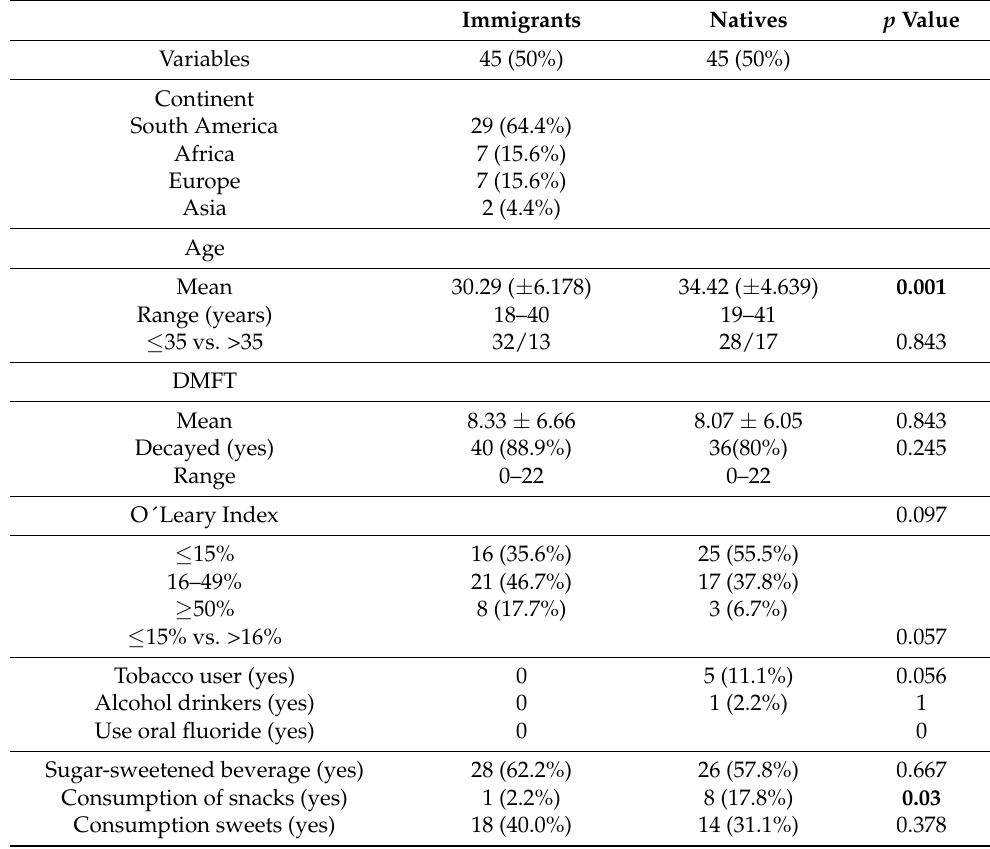
Table 1. Demographic characteristics, oral health and habits of the group of pregnant women included in the oral health preventive program (phase I) . DMFT: decayed, missing, filled teeth. In bold letters, statistically significant p